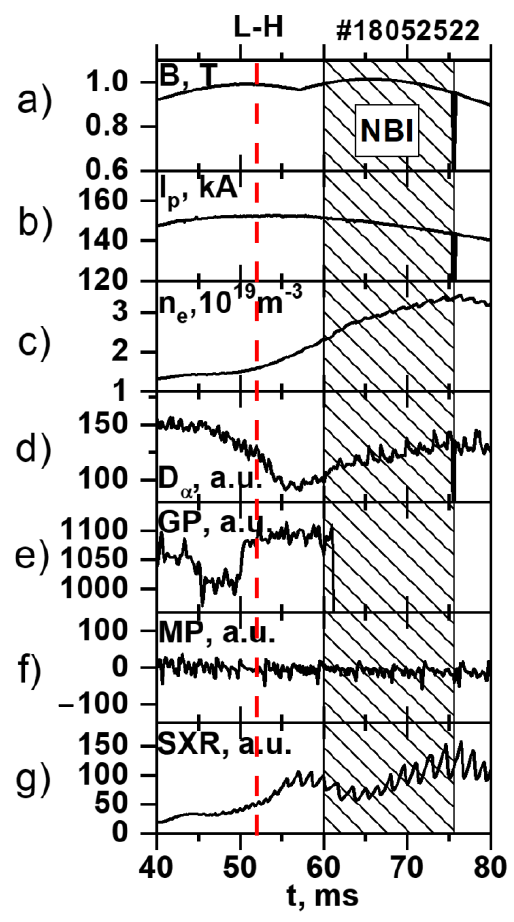
Figure 2. Plasma parameters during a TUMAN-3M discharge with a transition to H-mode: ( a ) toroidal magnetic field B τ , ( b ) plasma current I p , ( c ) electron density n e , ( d ) D α signal, ( e ) gas puff (puffing rate increased to achieve L–H transition), ( f ) magnetic probe signal, ( g ) soft X-ray (SXR) signal. Red, dashed line at 52 ms indicates the L–H transition. NBI introduced to the plasma at 60 ms (after the transition to H-mode) is indicated by a striped box.